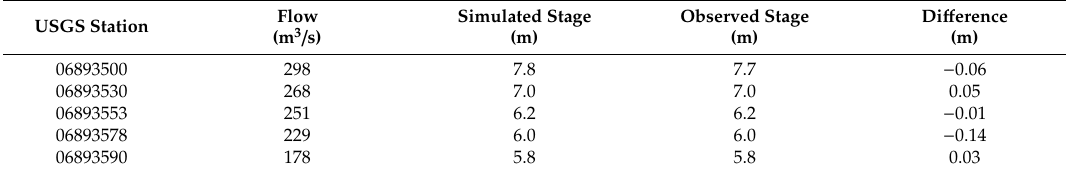
Table 4. HEC-RAS Model Calibration for the flood event of 17 May 2015.